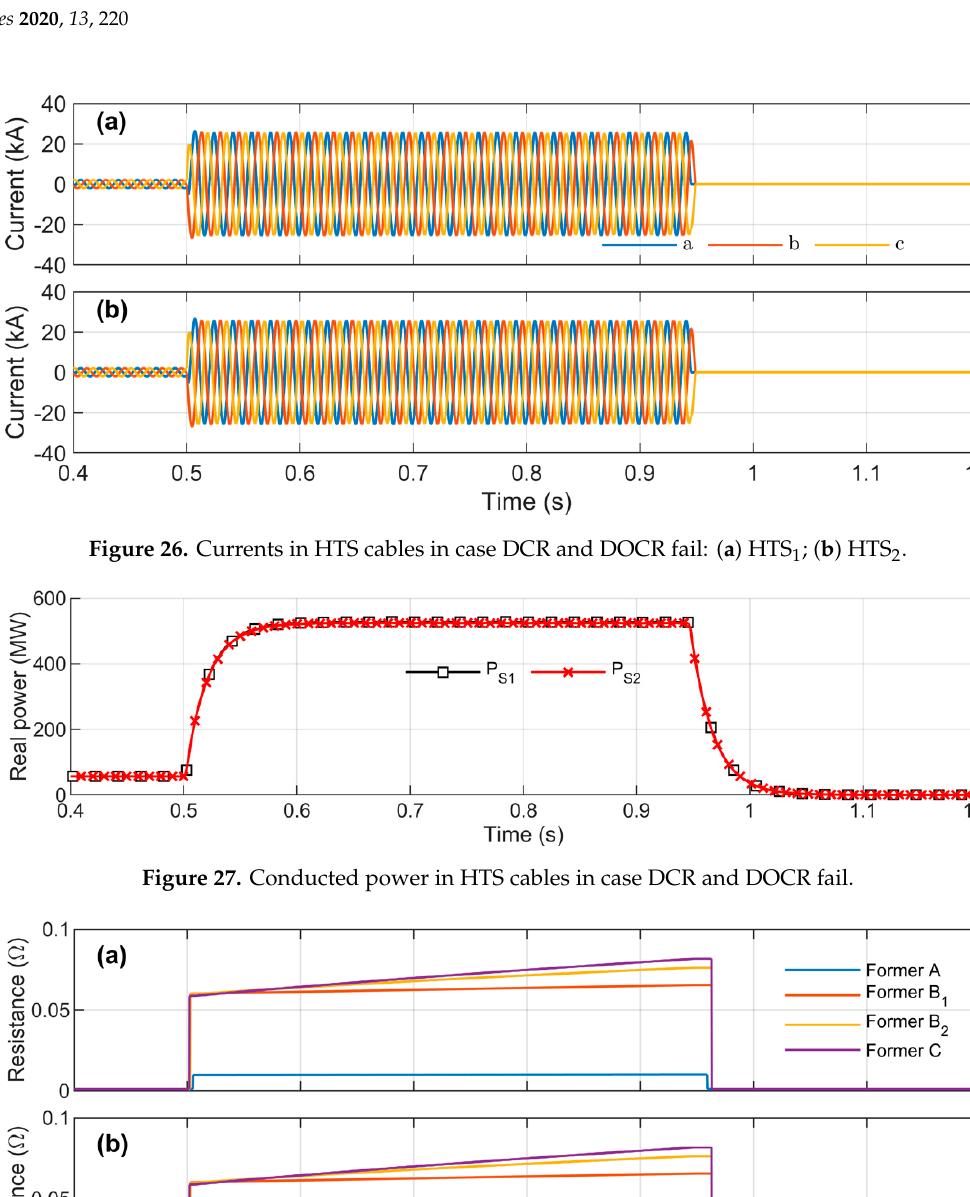
Figure 29. HTS cable temperatures in case DCR and DOCR fail: ( a ) HTS 1 ; ( b ) HTS 2 .